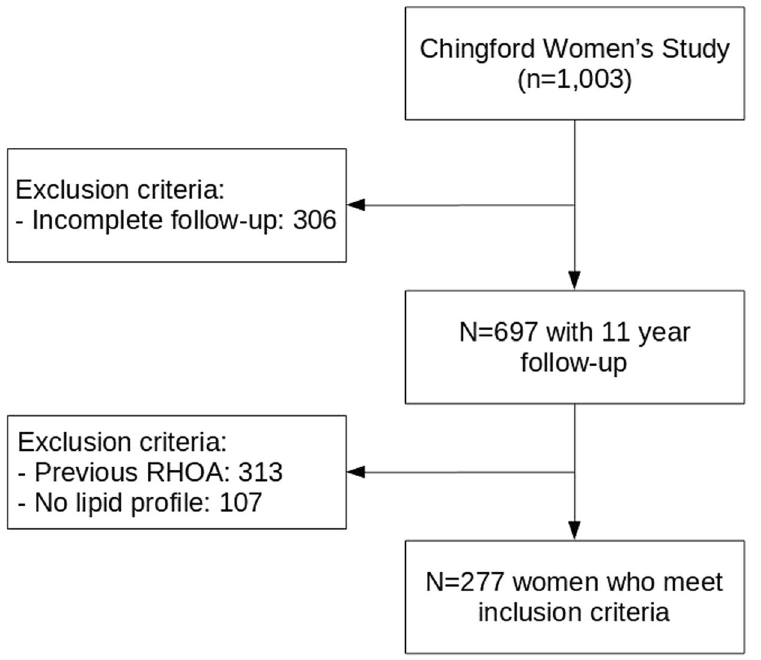
Figure 1. Flowchart of the study